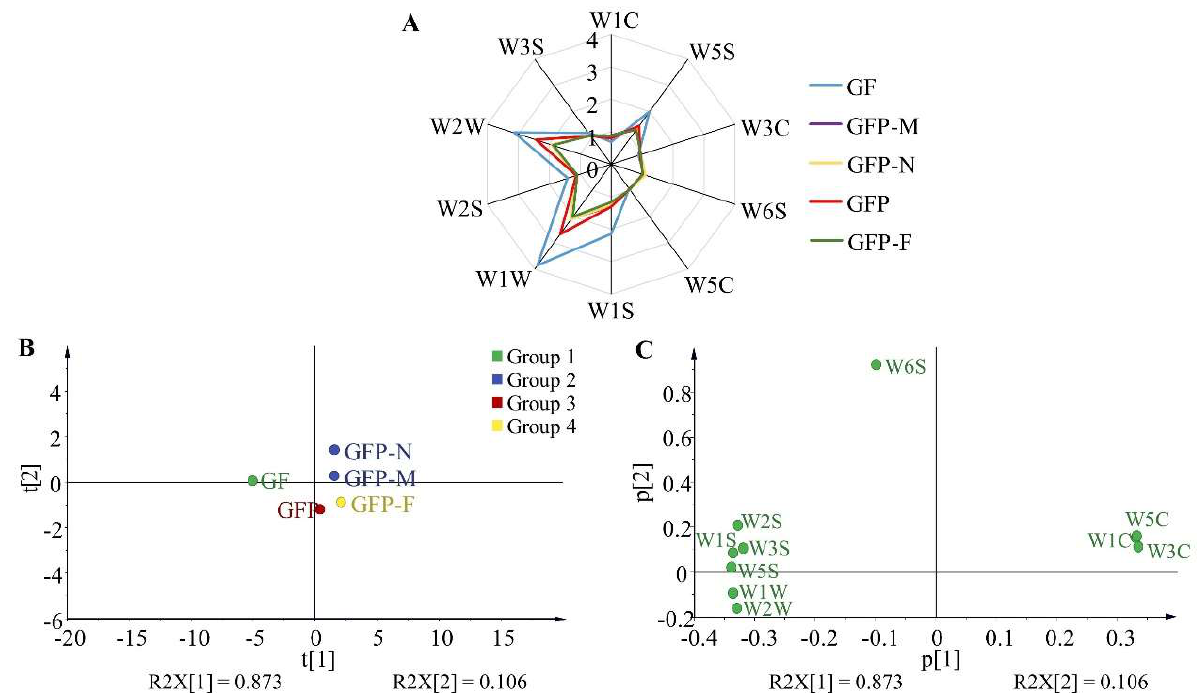
Figure 4. The odor information of five GFP processed decoction pieces. ( A ) Radar map of response value. ( B ) PCA analysis of electronic nose data. ( C ) Loadings analysis of electronic nose data.